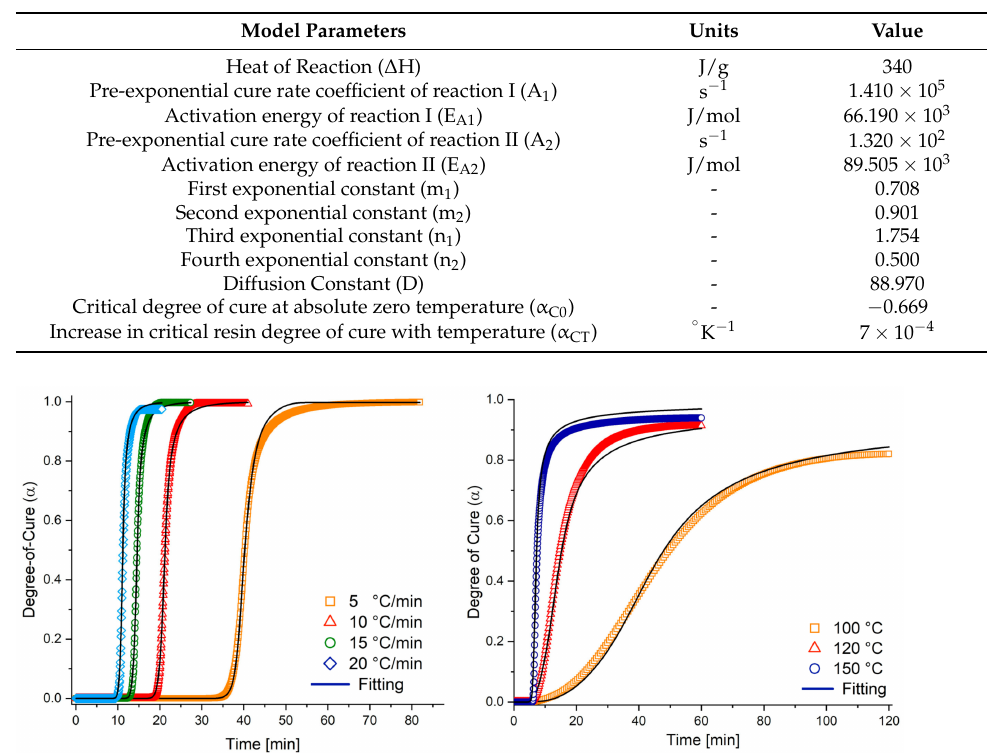
Table 1. OM12 resin system cure kinetics model parameters.